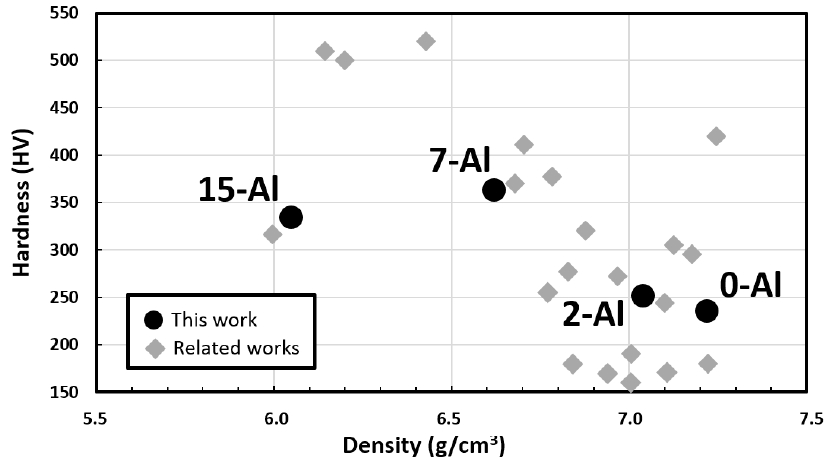
Figure 6. Materials property space for hardness vs. calculated density at room temperature of manufactured cast irons and related works, data from [18,20,21,25].